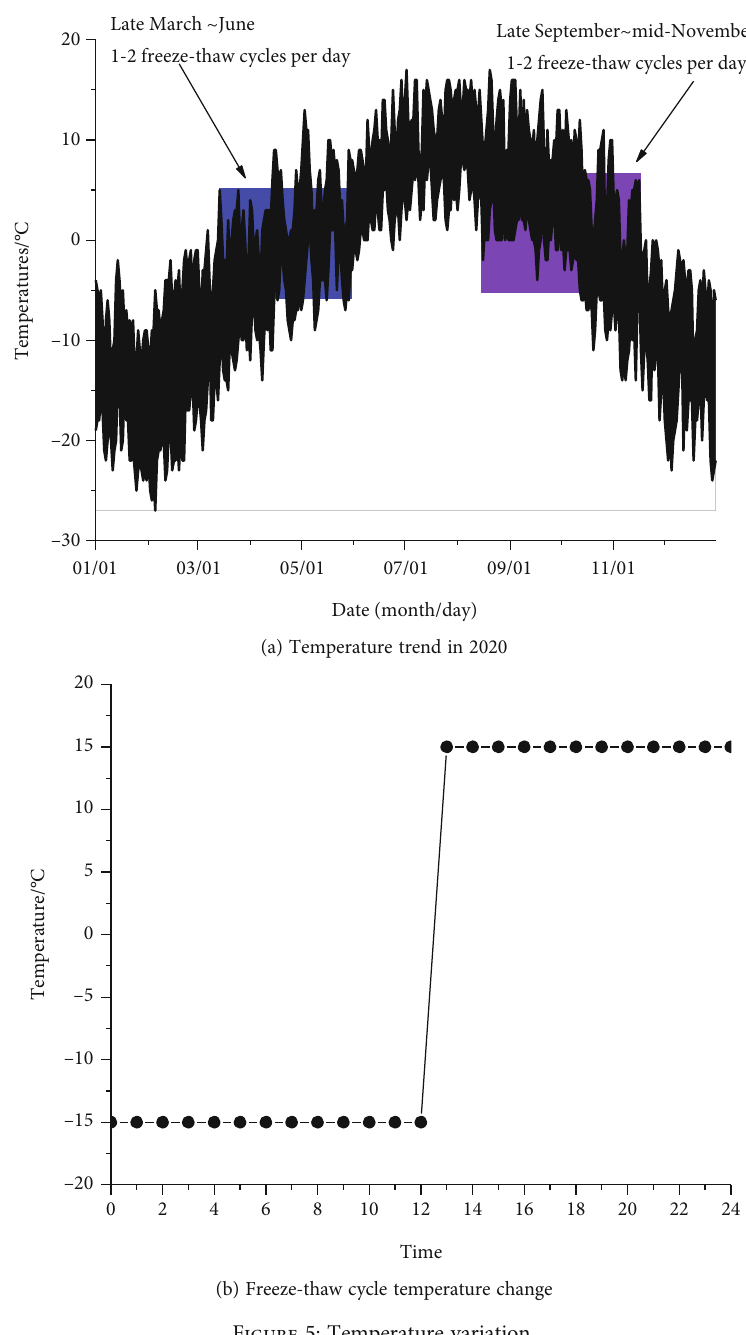
Figure 5: Temperature